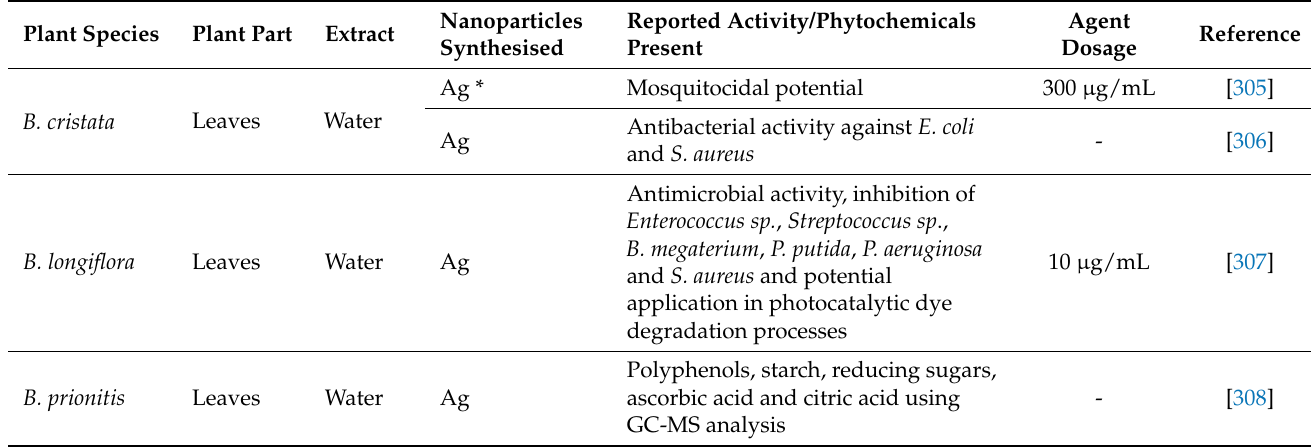
Table 13. Biological activity of synthesized nanoparticles from extracts of species of Barleria